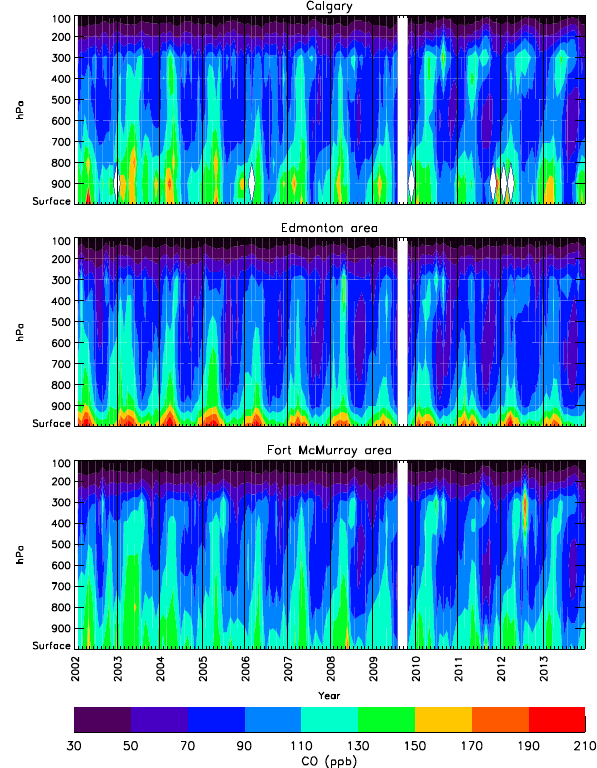
Figure 7. The 12-year interannual variation monthly averaged day- time MOPITT CO mixing ratios (ppb) as measured by MOPITT from January 2002 to December 2013 over the Calgary, Edmonton, and Fort McMurray